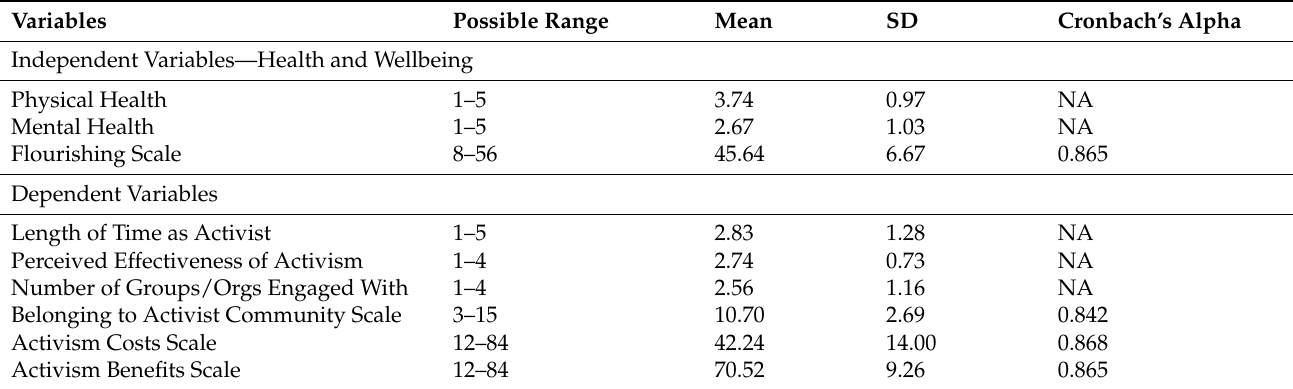
Table 2. Descriptive and Reliability for Study